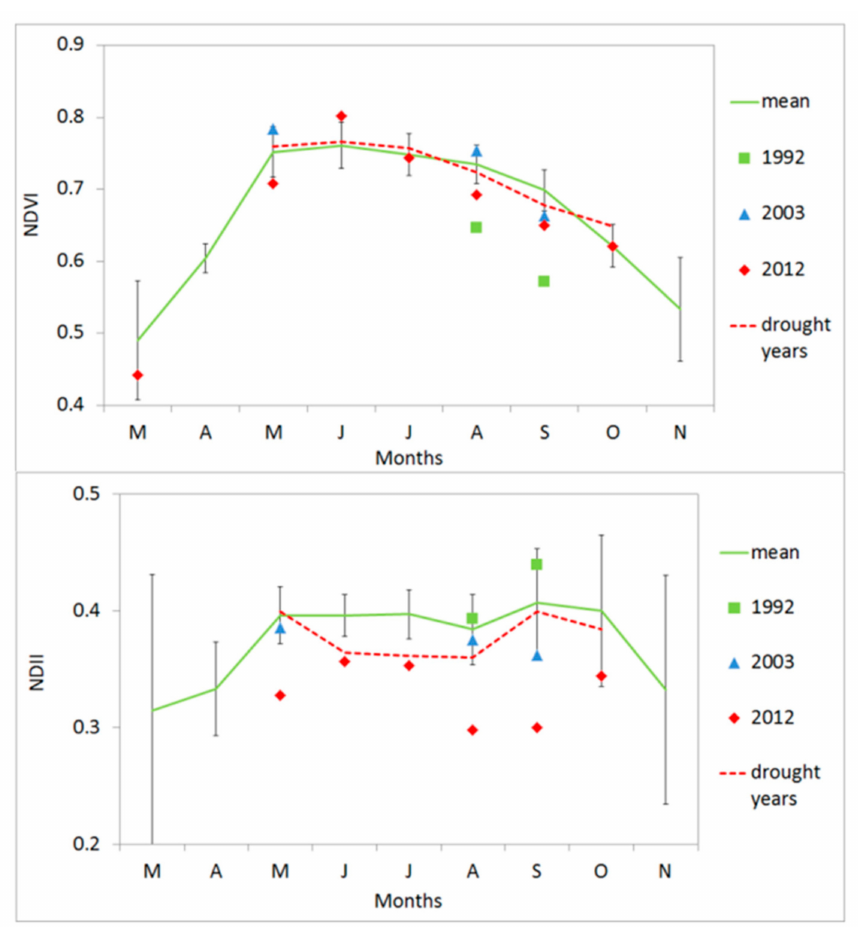
Figure 12. Monthly mean ( ± SD) normalized difference vegetation index (NDVI) (upper chart) and the normalized difference infrared index NDII (bottom chart) values (for 1984–2016) compared to the mean values of the drought years (1992, 2000–2001, 2003, 2011–2012) and average values of different months in 1992, 2003 and